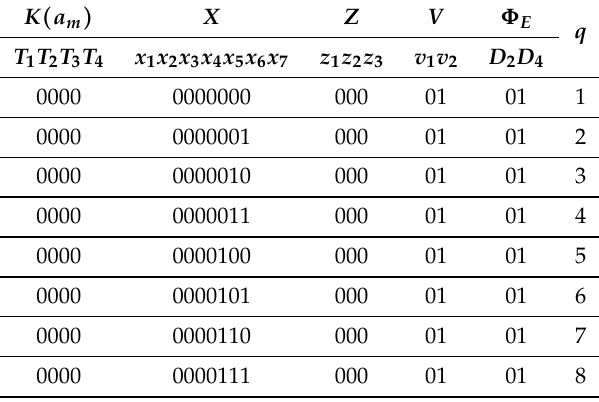
Table 6. Part of table of EMB of Mealy FSM U 5 ( S 1